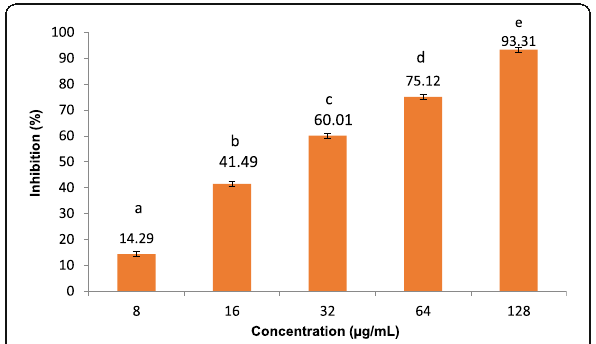
Fig. 1 A5-LOX inhibitory activities of ethanol extract of bark of Flacourtia indica. Results are presented as mean ± SE ( N = 3). Means followed by the same letter are not significantly different at p <